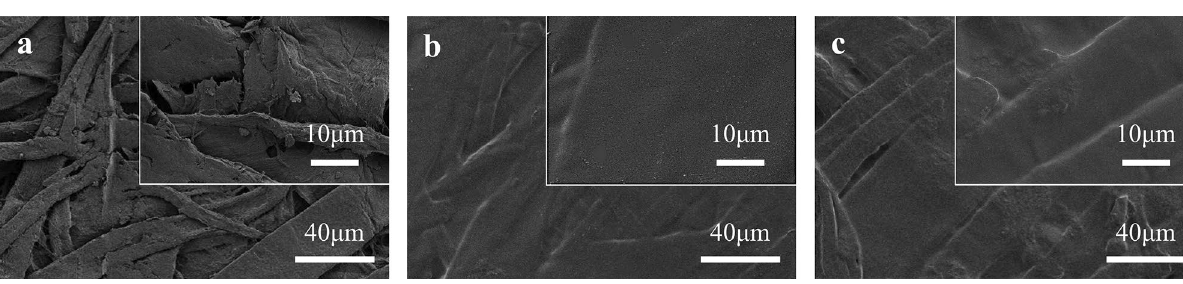
Figure 11. SEM images of ( a ) base paper ( b ) PVA coated paper, and ( c ) PVA/CNF coated